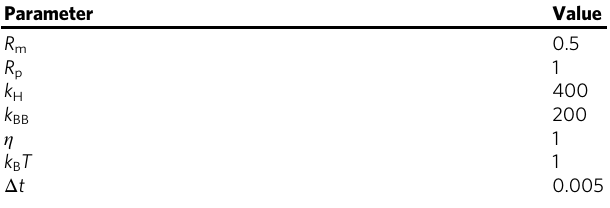
Table 1 List of parameters in Brownian dynamics simulations